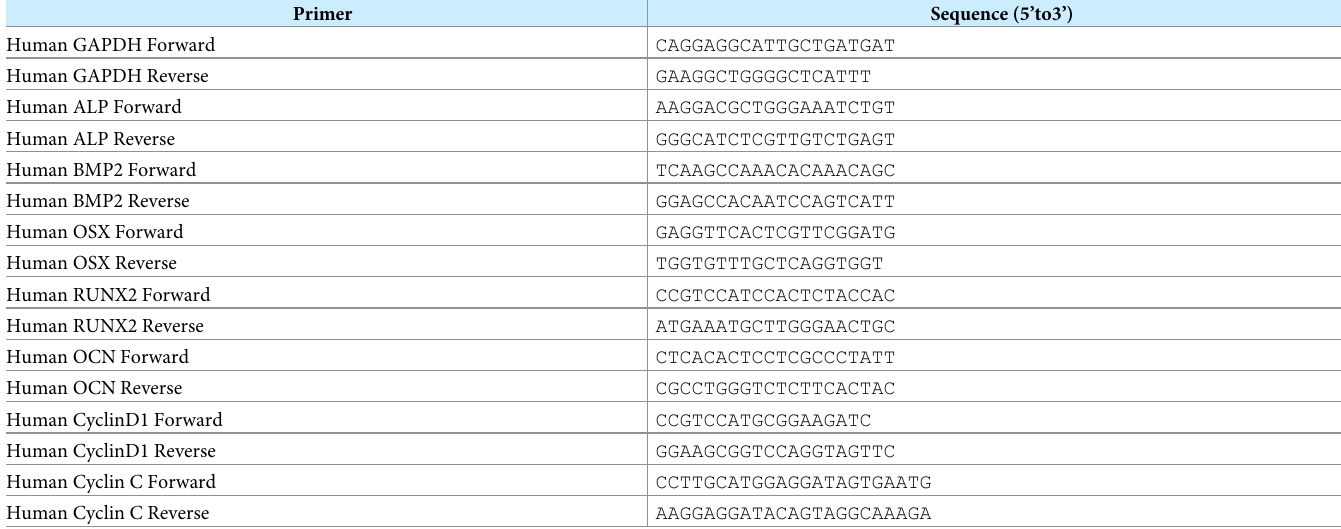
Table 1. List of the primer sequences for qRT-PCR assays.